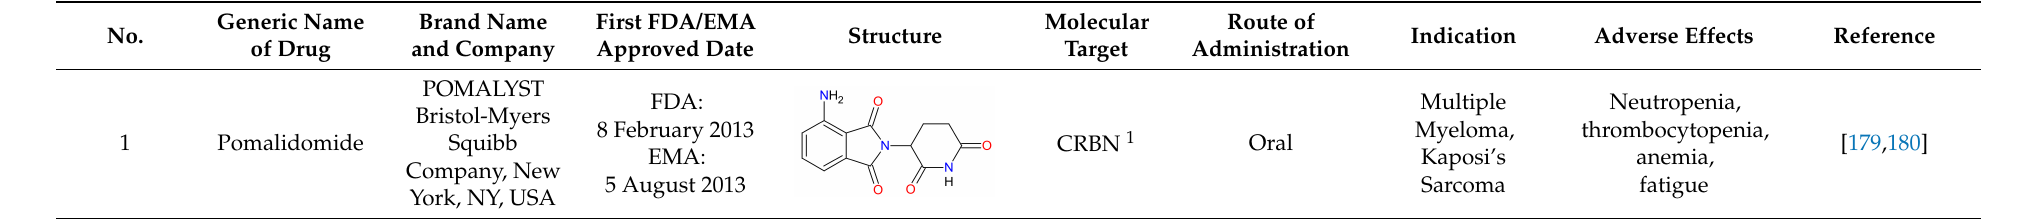
Table 9. Features of the immunomodulatory drug approved by the Food and Drug Administration (FDA) from 2011 to